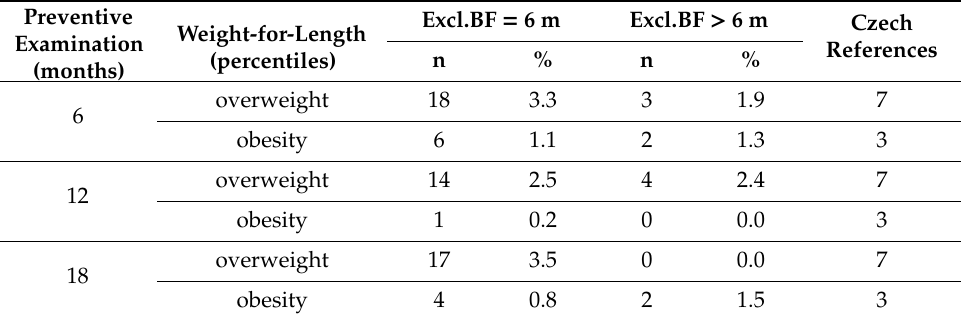
Table 4. Proportion of overweight and obese children breastfed for 6 months and longer than 6 months compared to the Czech references at 6, 12, and 18